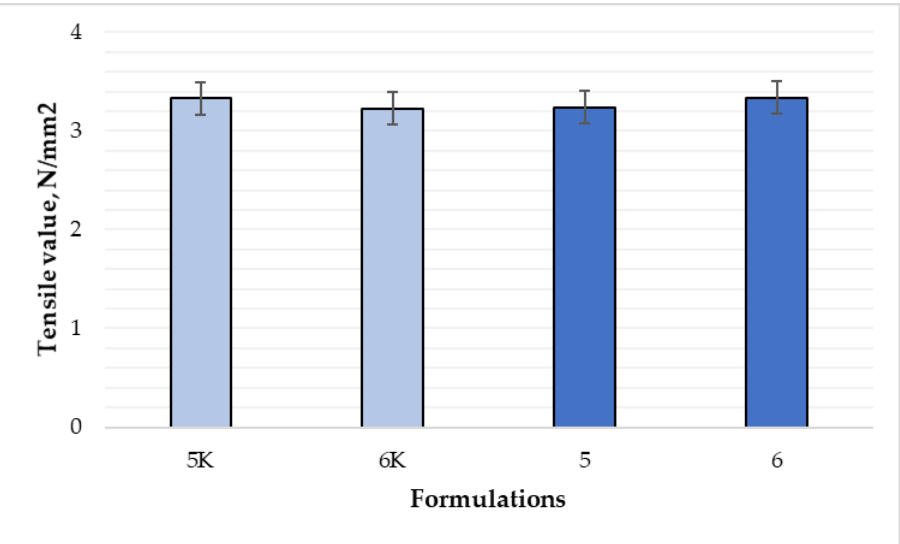
Figure 12. Comparison of tensile value of films by composition (n = 6). The composition values are given in Table 1. p < 0.05 between 5 and 5K; 6 and 6K; 5 and 6 compositions.